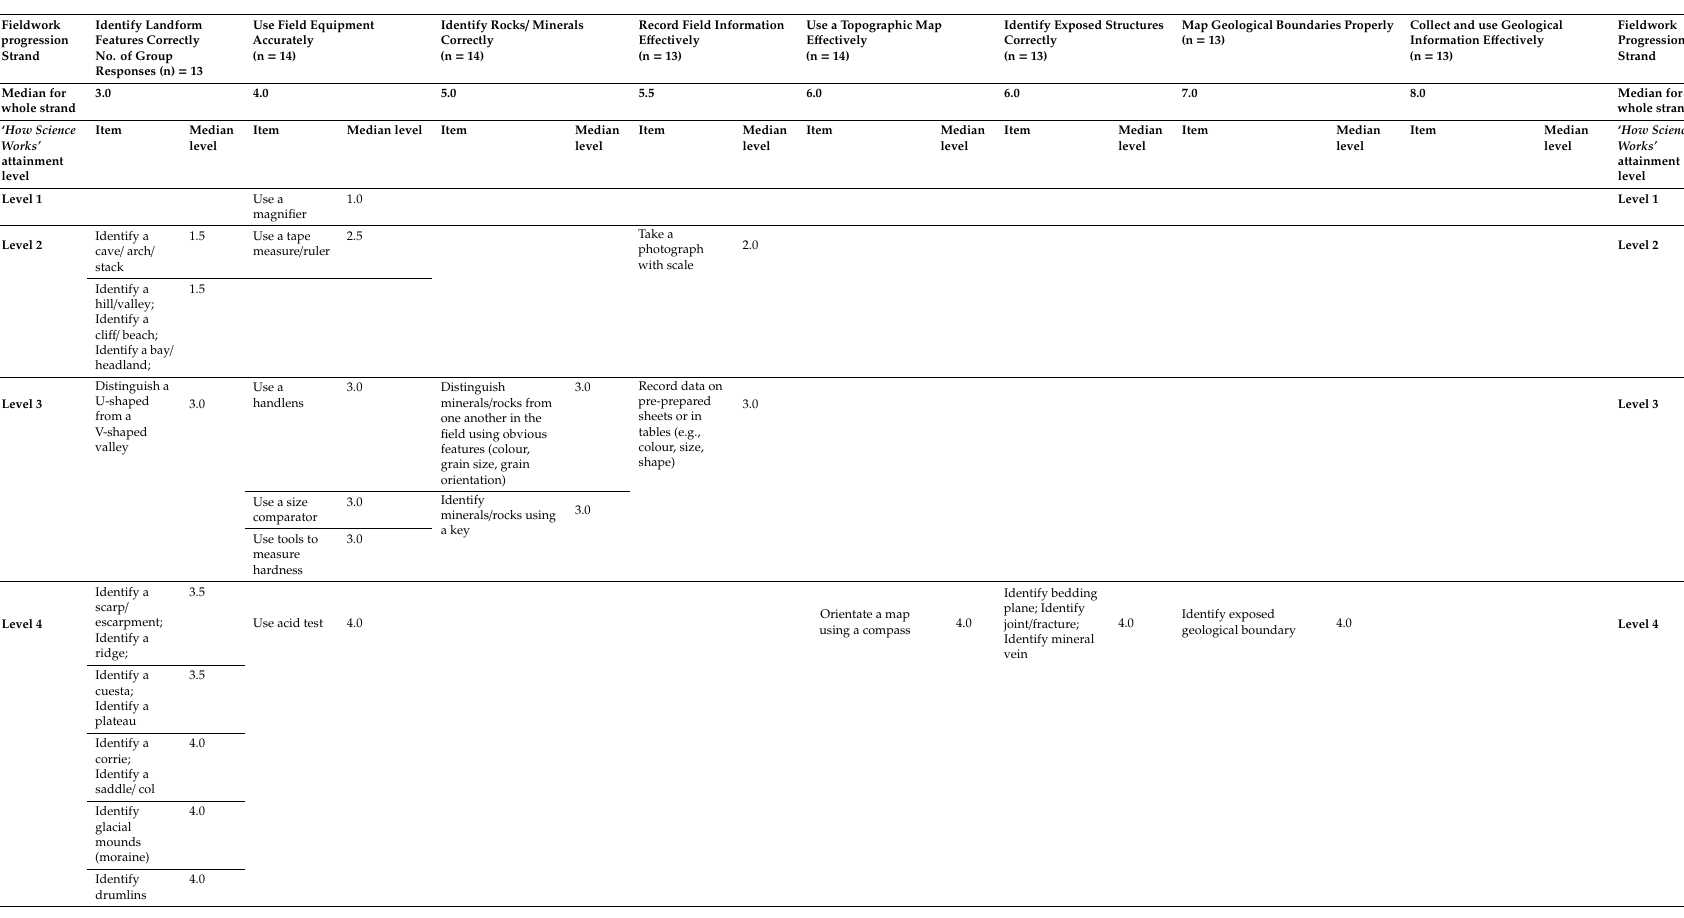
Table 3. Progression identified in the fieldwork strands, listed in order of increasing median and so of general increase in thinking levels across the table. Fieldwork progression